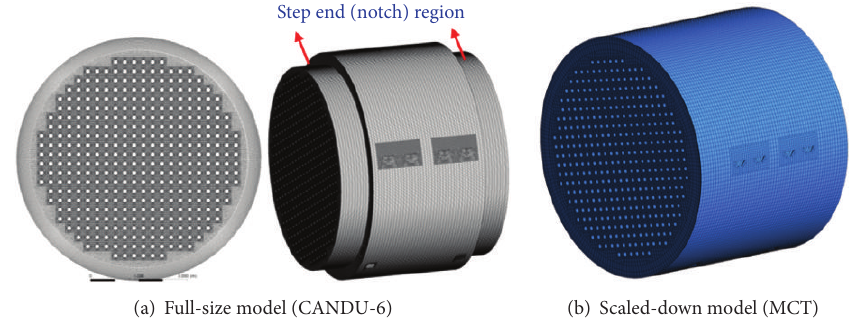
Figure 3: Mesh configuration for the full-size and scaled-down